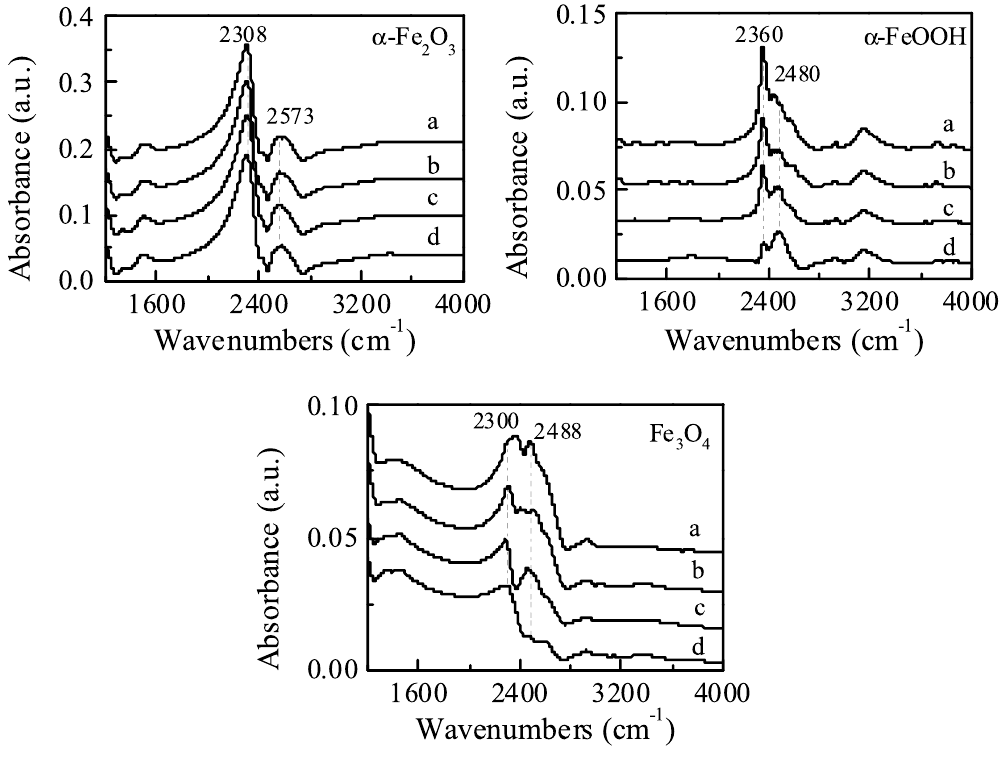
Figure 5. ATR-FTIR spectra of iron oxides suspended in D 2 O bubbling ozone for different time: ( a ) 0 min, ( b ) 2 min, ( c ) 5 min and ( d ) 10 min. (catalyst dose: 100 g L − 1 , pD: